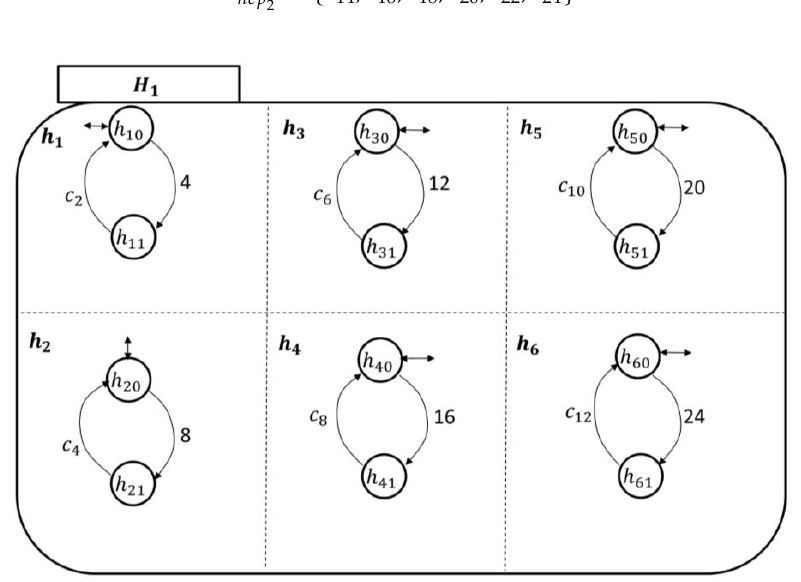
Figure 16. The hospitalist automaton (𝑯 𝟏 ) transitional model.